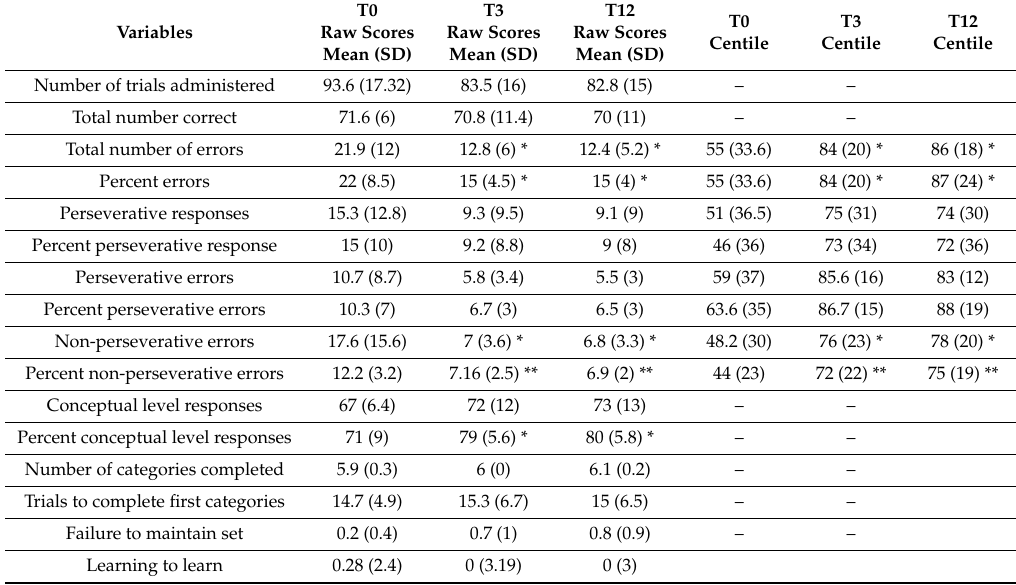
Table 4. The Wisconsin Sorting Card Test results before and on LNAAs